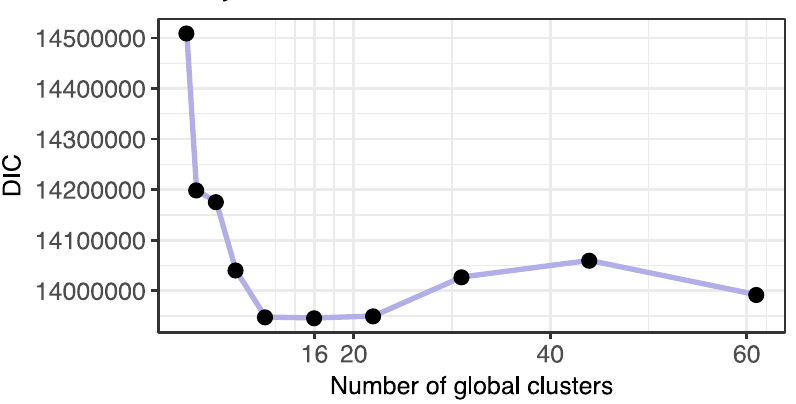
Fig 20. Devianceinformation criterion (DIC) as a method for selecting number of clusters in the kidney cancer dataset. The plot shows the DIC for a range of numbers of globalclusters when the numberof local clusters is set to three. The DIC is minimizedfor 16 globalclusters.